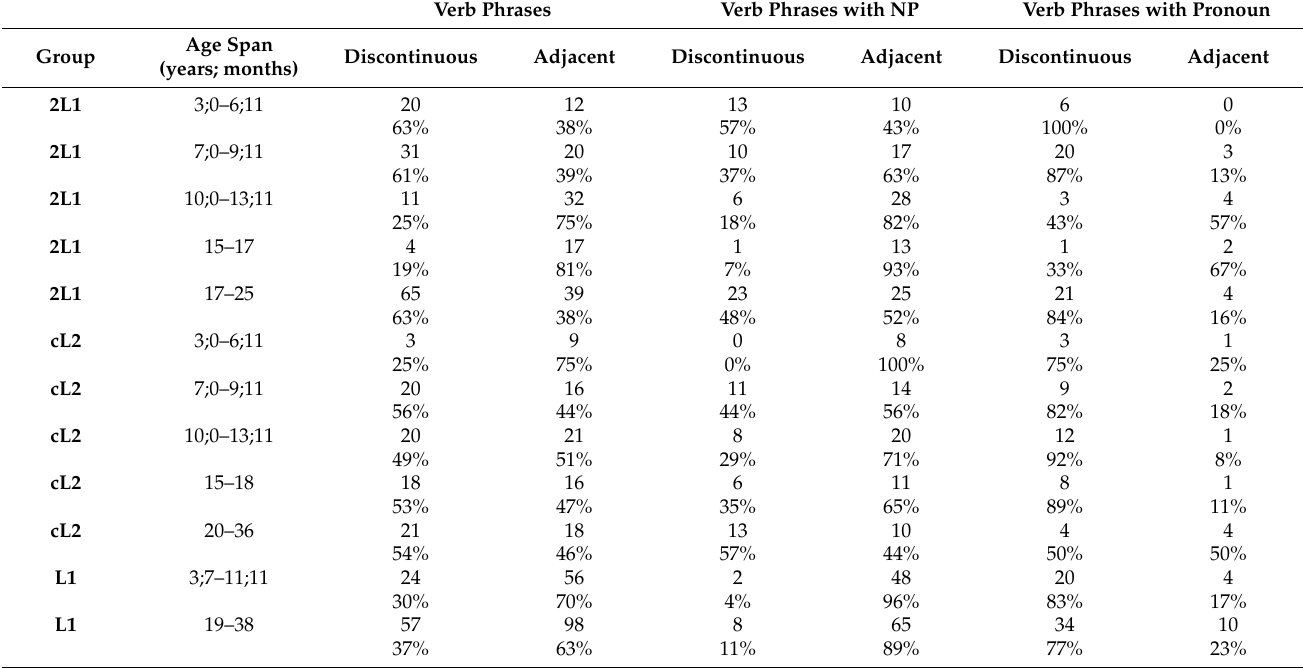
Table A1. Exact numbers of tokens for each word order type and group of participants included in the study (narrative